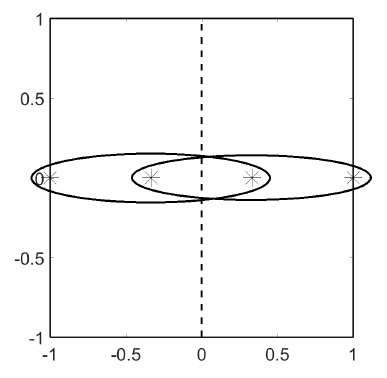
Figure 3. Stencil grouping example.